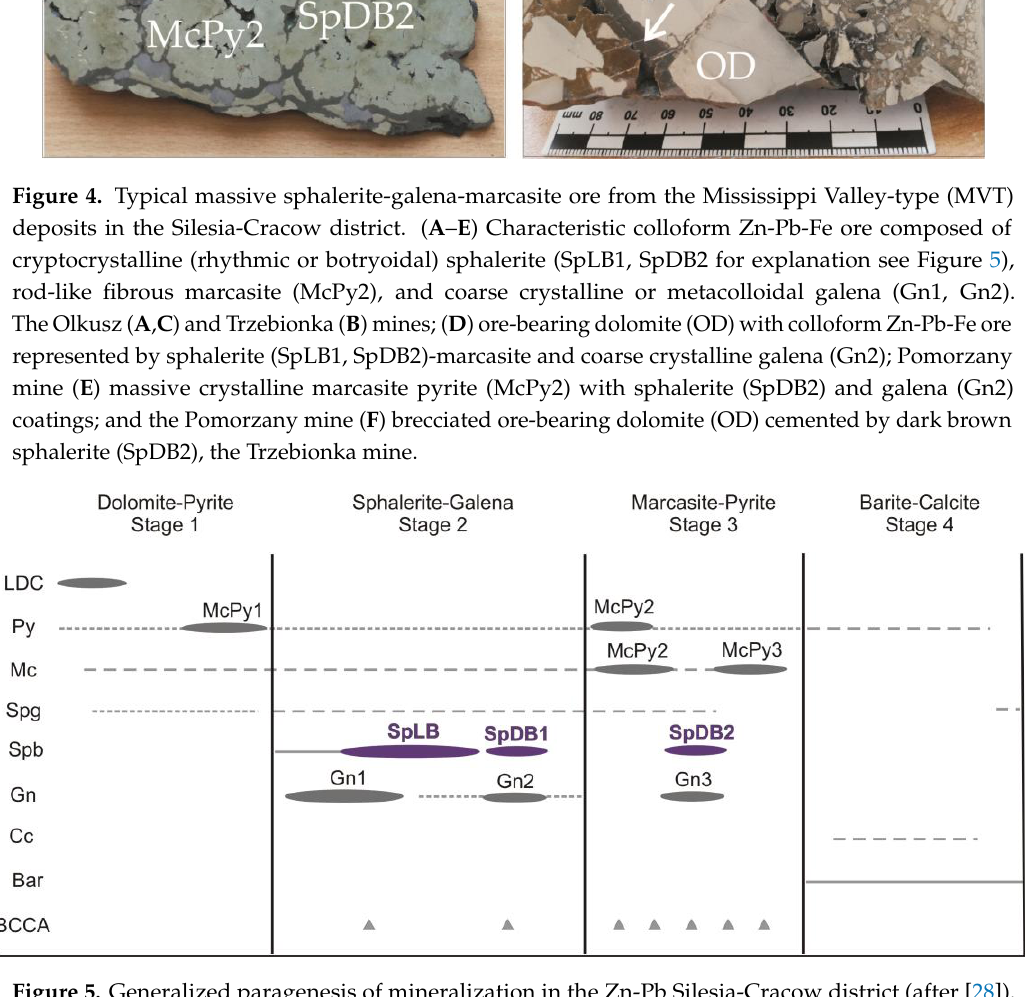
Figure 4. Generalized paragenesis of mineralization in the Zn-Pb Silesia-Cracow district (after [28]). LDC, late dolomite cement; McPy1, 2, 3, the successive stages of marcasite (Mc) and pyrite (Py); Gn1, 2, 3, the successive stages of galena; Spg, granular sphalerite; Spb, banded sphalerite; SpLB, light coloured, banded or colloform sphalerite from stage 2; SPDB1, first dark banded sphalerite in stage 2; SpDB2, second dark banded sphalerite in stage 3; Cc, calcite; Bar, barite; and BCCA, breccia.